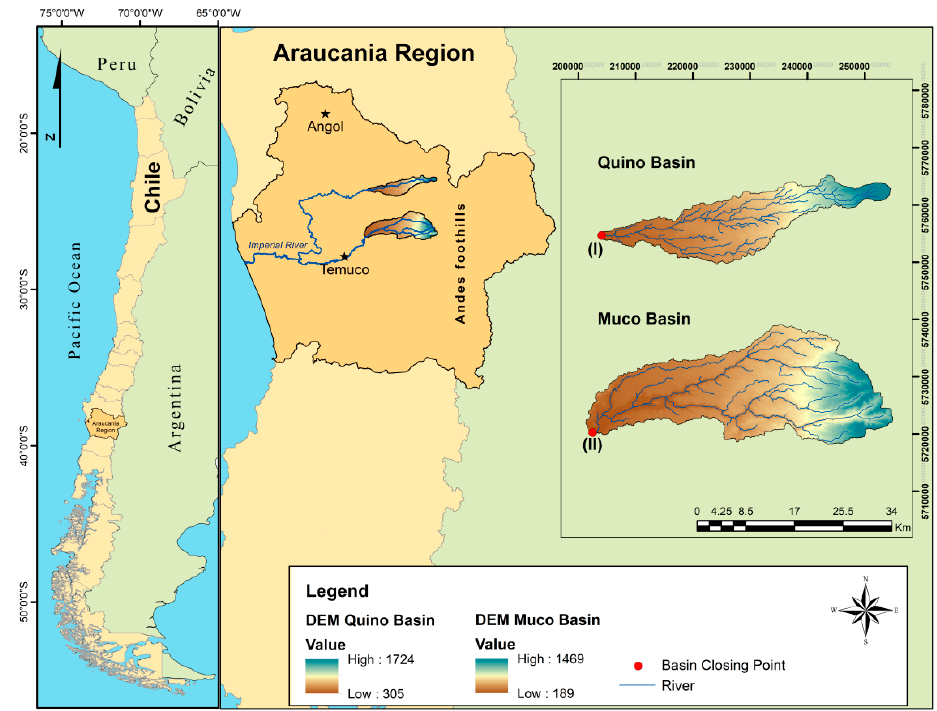
Figure 1. Geographical location map of Quino and Muco basins. Gaugin Stations: (I) Rio Quino en Longitudinal and (II) Rio Muco en Puente Muco.